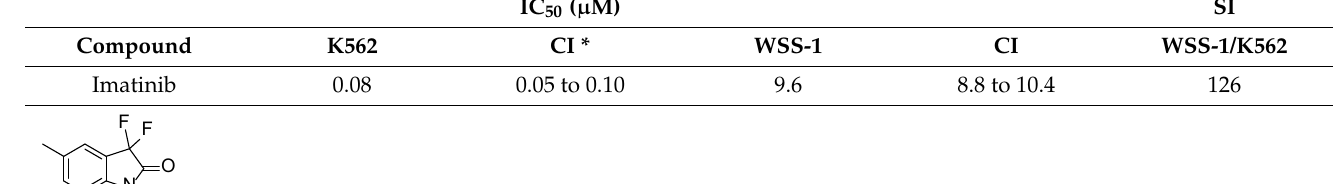
Figure 2. Screening of imatinib and its 2a–e and 3a–e derivatives at 10 µM concentration, against human cell lines K562 (in red) and WSS-1 (green). Bars represent the mean ± standard deviation. Table 1 shows the IC 50 and SI values of imatinib and its most cytotoxic analog, 3b, on K562 cells. Table 1. Cytotoxic activity and selectivity index of imatinib and derivative 3b in the K562 and WSS-1 cells. IC 50 ( µ M)